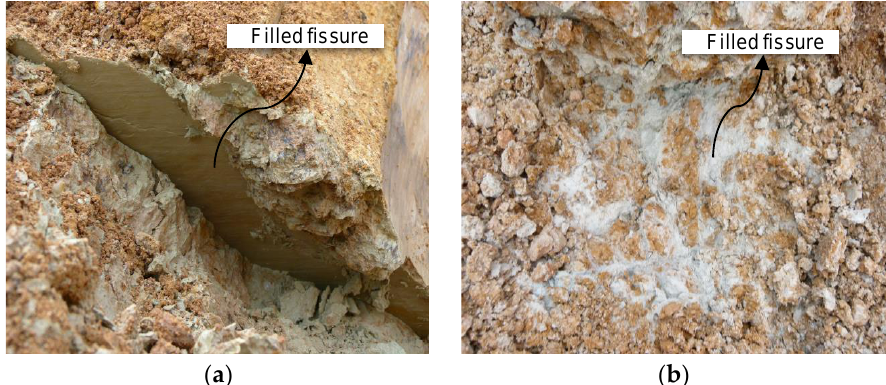
Figure 2. Filled fissures in the expansive soil. ( a ) Primary filled fissures; ( b ) secondary filled fissures.